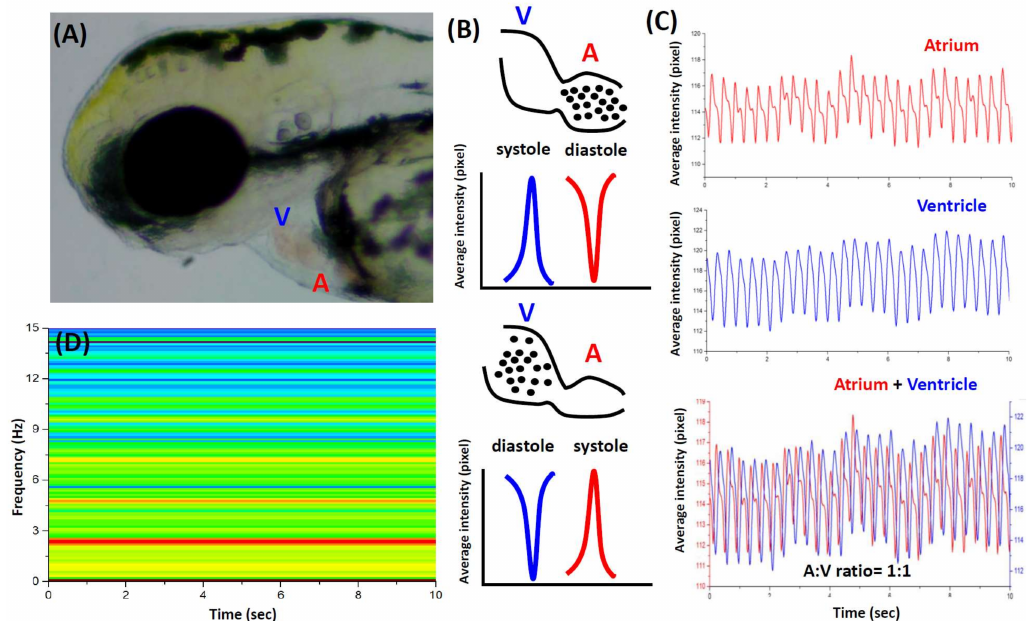
Figure 2. Cardiac rhythm detected by dynamic pixel change method. ( A ) the heart position of zebrafish embryos aged 72 hpf; ( B ) schematic diagram showing the principle of the dynamic pixel-changing method used in this study; ( C ) the dynamic pixel change pattern in the atrium (upper panel), the ventricle (middle panel) and both (lower panel) for the zebrafish aged 72 hpf; ( D ) short time Fourier transformation of heartbeat for untreated zebrafish embryos aged 72 hpf (V, ventricle; A,